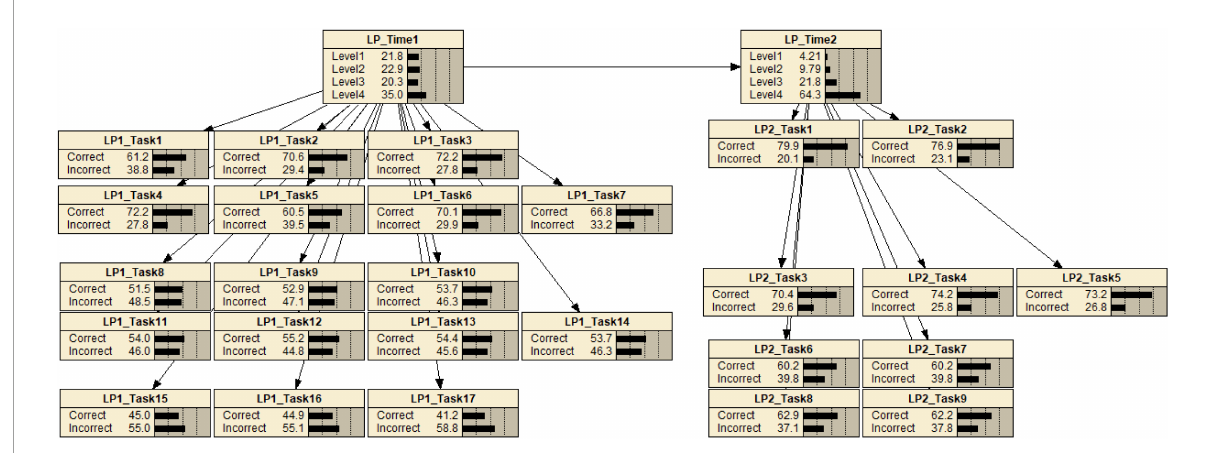
FIGURE5 A DBN for an LP for IP addressing skills, before observations.